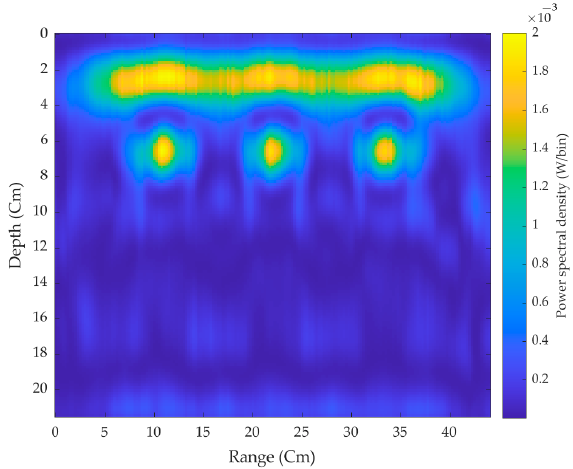
Figure 13. 2-D cross-surface scanned image with three targets.